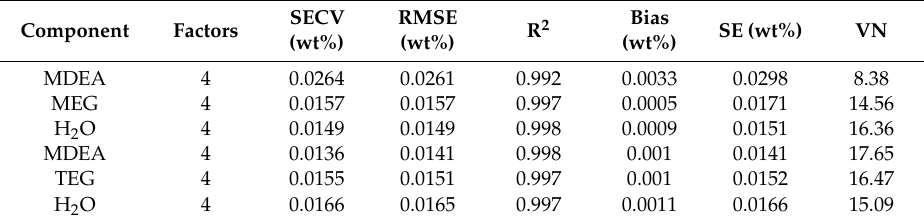
Figure 5. Actual vs. predicted values of three-component systems; the MDEA-MEG-H 2 O system ( a ) and MDEA-TEG-H 2 O system ( b ). Table 4. Summary of results for three-component systems.